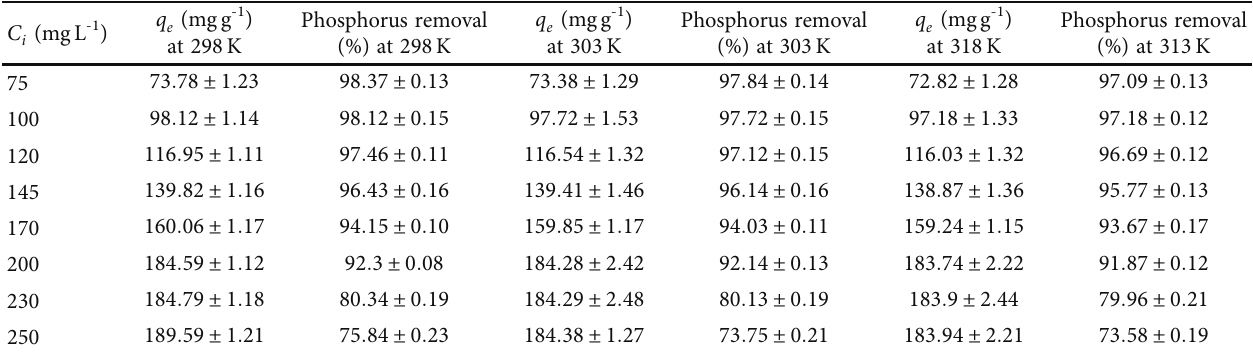
Table 4: Phosphorus capacity of M-ARM at various initial phosphorus concentrations.